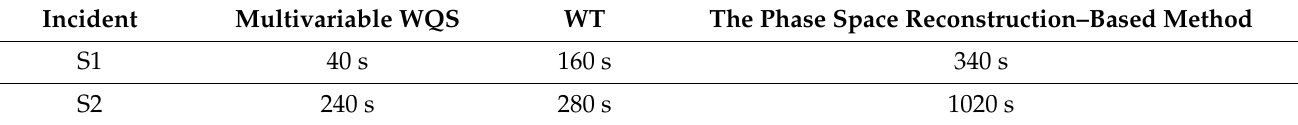
Table 4. Comparison of the performance of the three different methods for detecting the incident start time. The absolute time difference between the actual reported time by the Traffic Management Centre (TMC) and the detected time from the multivariable WQS, WT from the best sensor and the phase space reconstruction–based methods are